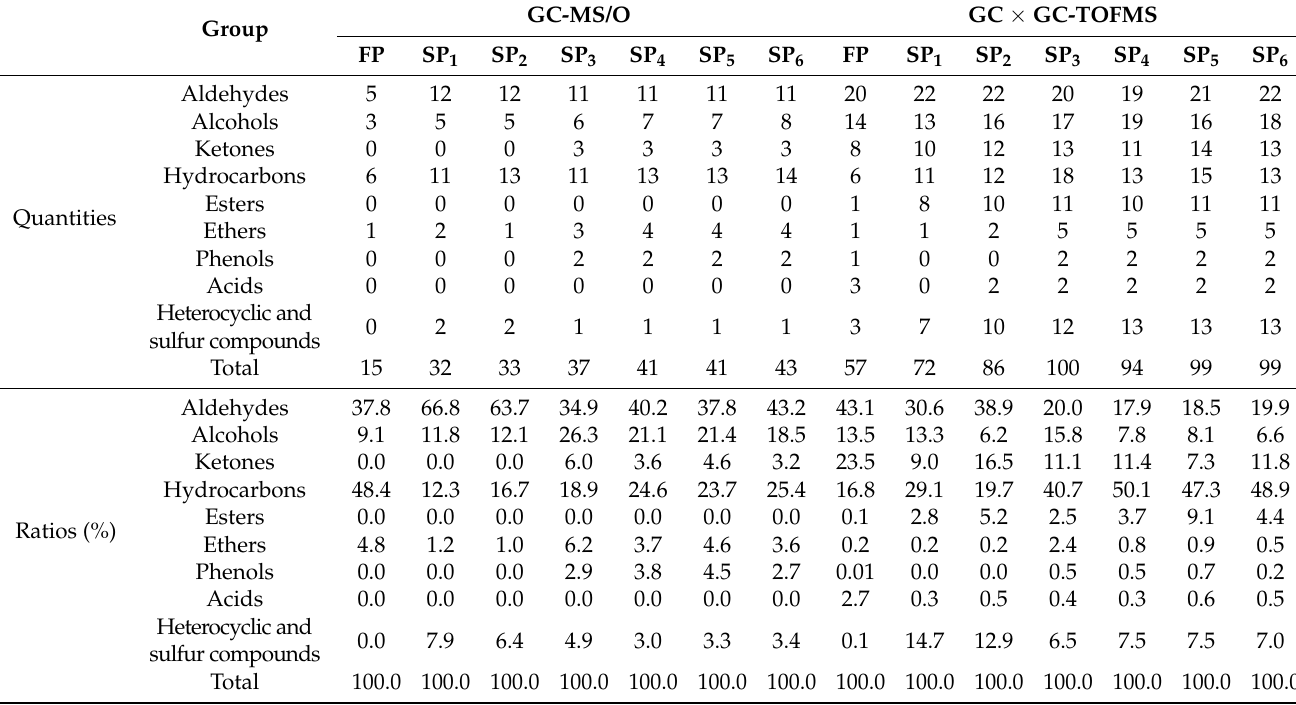
Table 1. The comparison of kinds and content ratios of volatile compounds by gas chromatography-mass spectrome- try/olfactometry (GC-MS/O) and two-dimensional gas chromatographic combined with time-of-fight mass spectrometry (GC ×